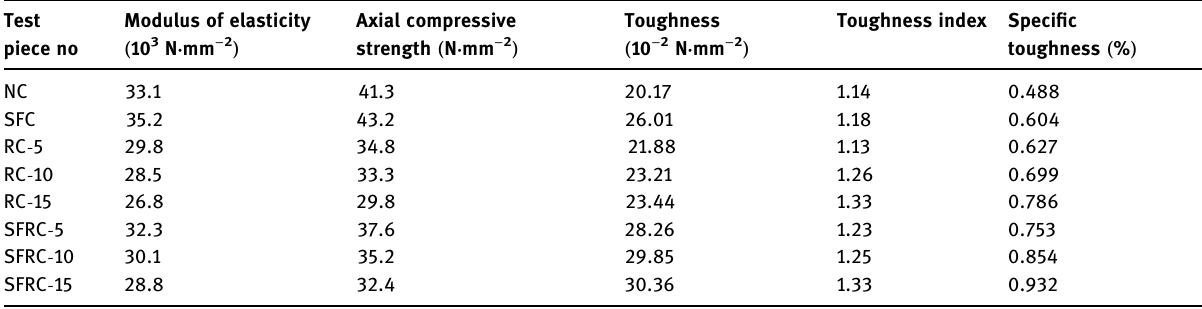
Table 3: Axial compression test results of prismatic specimens